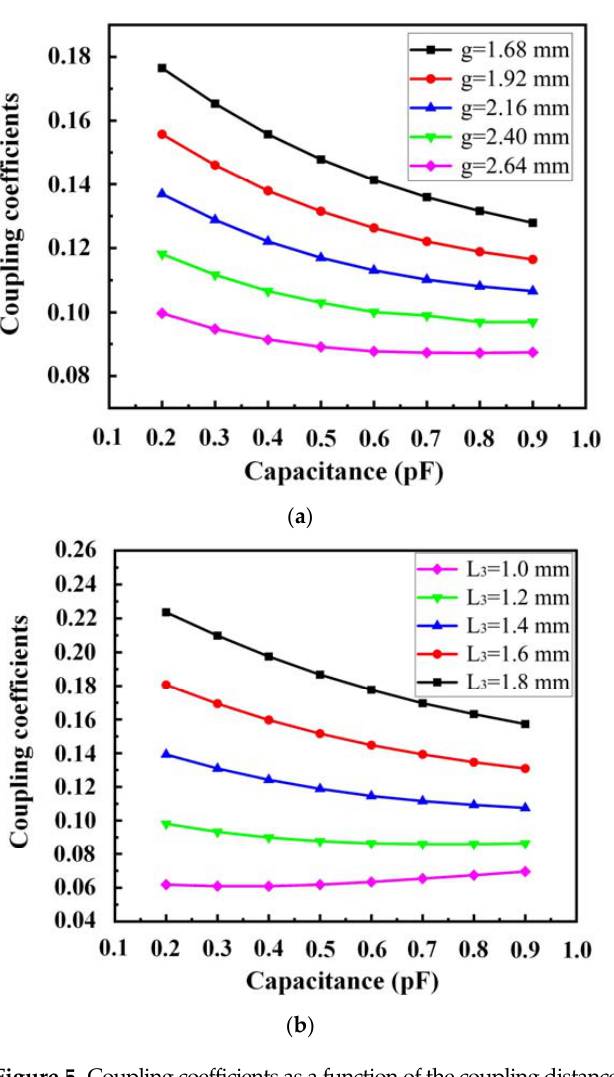
Figure 5. Coupling coefficients as a function of the coupling distance, varying with different C v . ( a ) g; ( b ) L 3 .